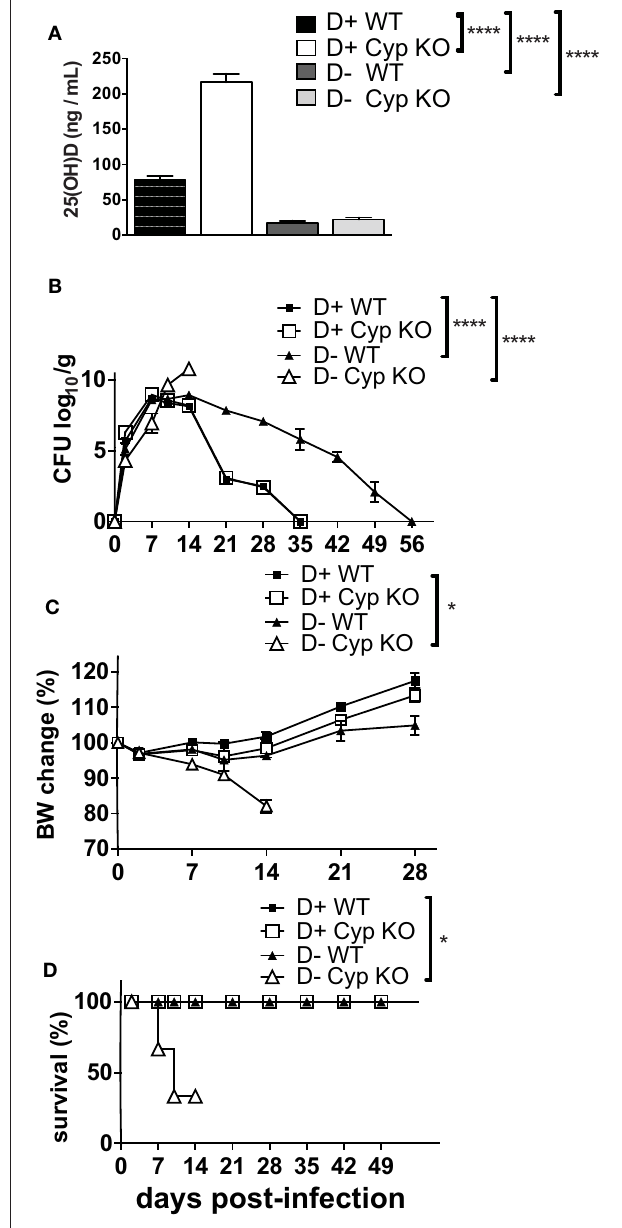
FIGURE 1 | Increased susceptibility of D- mice to C. rodentium infection. (A) Serum 25(OH) D levels in 8 week-old D + WT, D + Cyp KO, D- WT, and D- Cyp KO mice. Values are the mean ± SEM of a total n = 6–13 mice/group. Mice were infected with C. rodentium and (B) fecal shedding of the pathogen was monitored, (C) the percent original body weight (BW), and (D) the survival rate were plotted vs. days post-infection. The values (B–D) represent the mean ± SEM of n = 3–5 mice/group and from one representative of two independent experiments. One-way ANOVA with Bonferroni post-hoc tests (A) , Two-way ANOVA with Bonferroni post-hoc tests (B, C) and log-rank test (D) were used to determine significance. * P < 0.05, **** P <